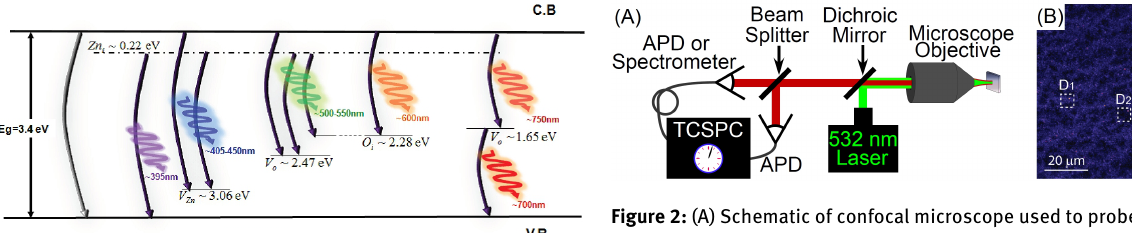
Figure 1: Schematic band diagram of the deep-level emissions in ZnO based on the reported data. Reproduced with permission from Ref. [36].